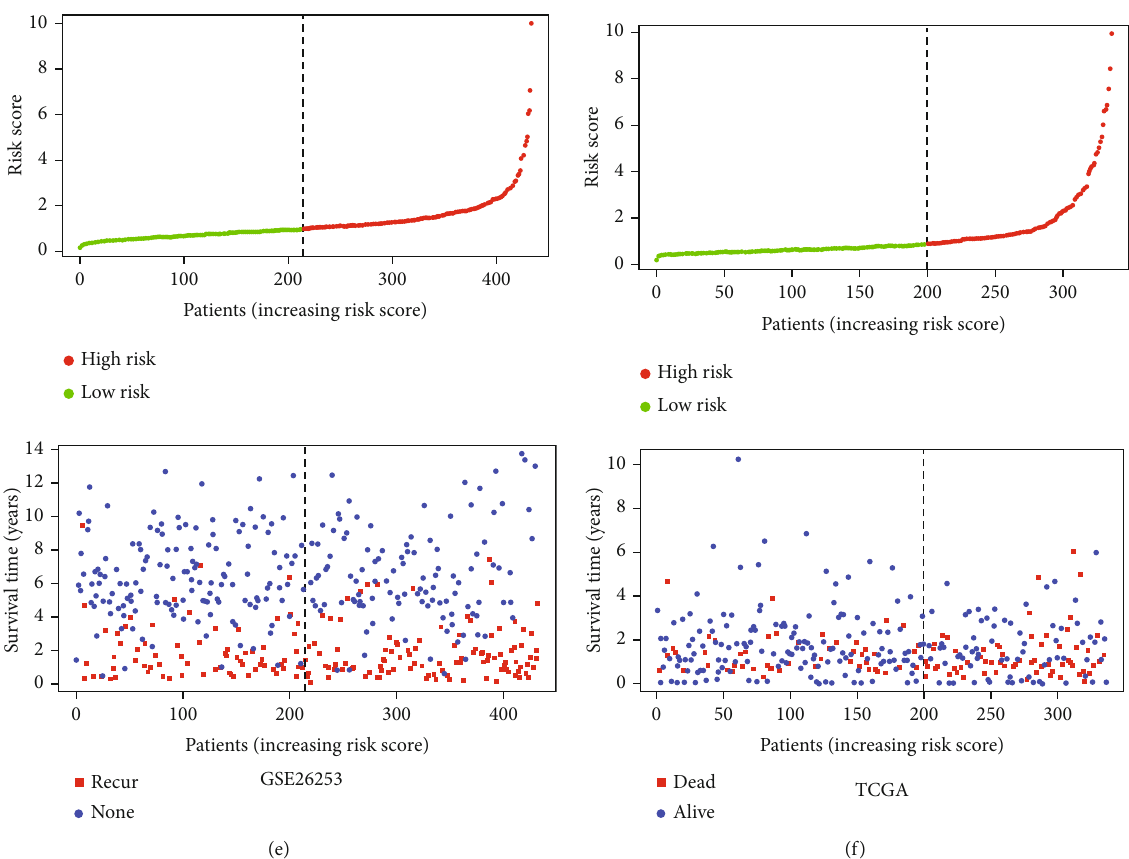
Figure 5: External validation of the prognostic signature. (a – c) Kaplan – Meier survival analysis of the prognostic signature for predicting OS in the GSE84437, GSE26253, and TCGA cohorts. (d – f) The risk score distribution and the survival status of patients in the GSE84437, GSE26253, and TCGA